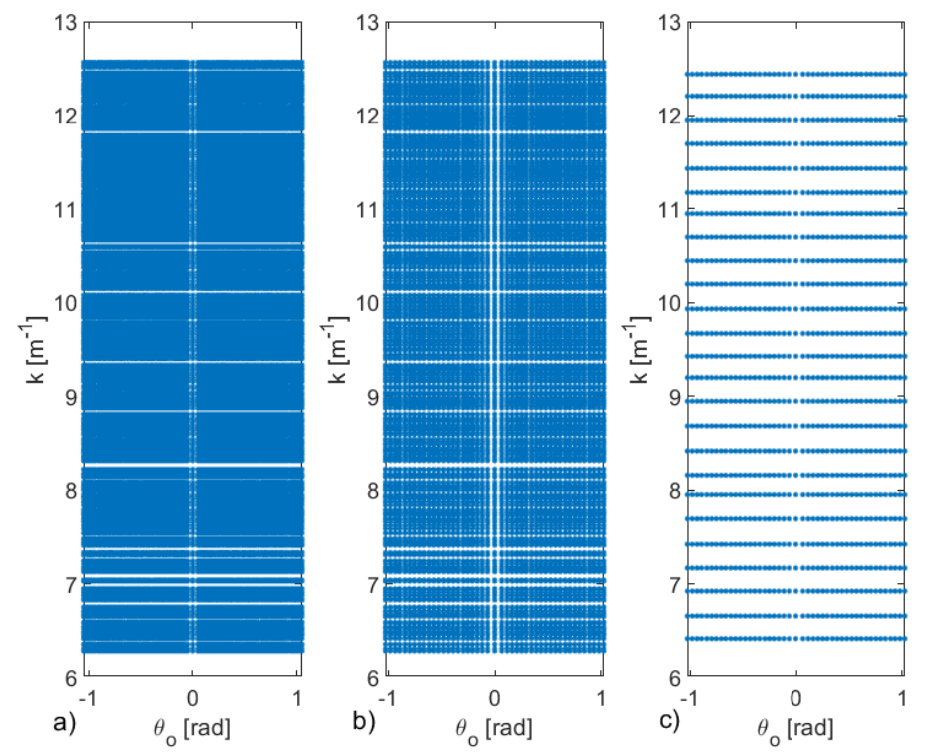
× { θ } N 2 built from the optimal grid oj j = 1 i = 1